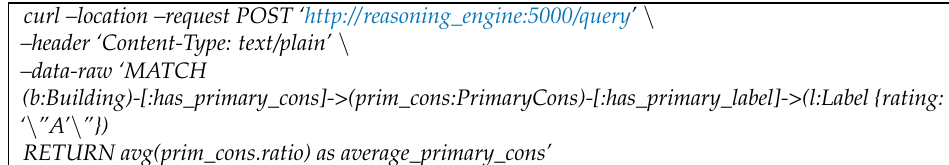
Table 3. Retrieve average primary consumption.